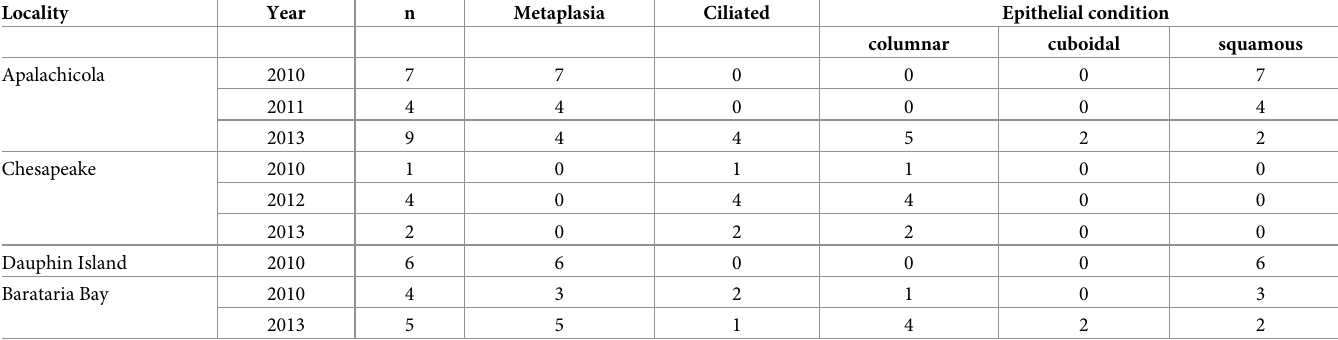
Table 1. Specimens and ctenidial examinations. n is the number of specimens from each locality and year successfully examined. Ciliated—number of specimens with cil- iated ctenidial branches. Epithelial condition—condition of ctenidial branch epithelia. Columnar epithelia are the normal condition, cuboidal and squamous (stratified) are metaplasial conditions. A single metaplasia specimen may possess multiple epithelial types.